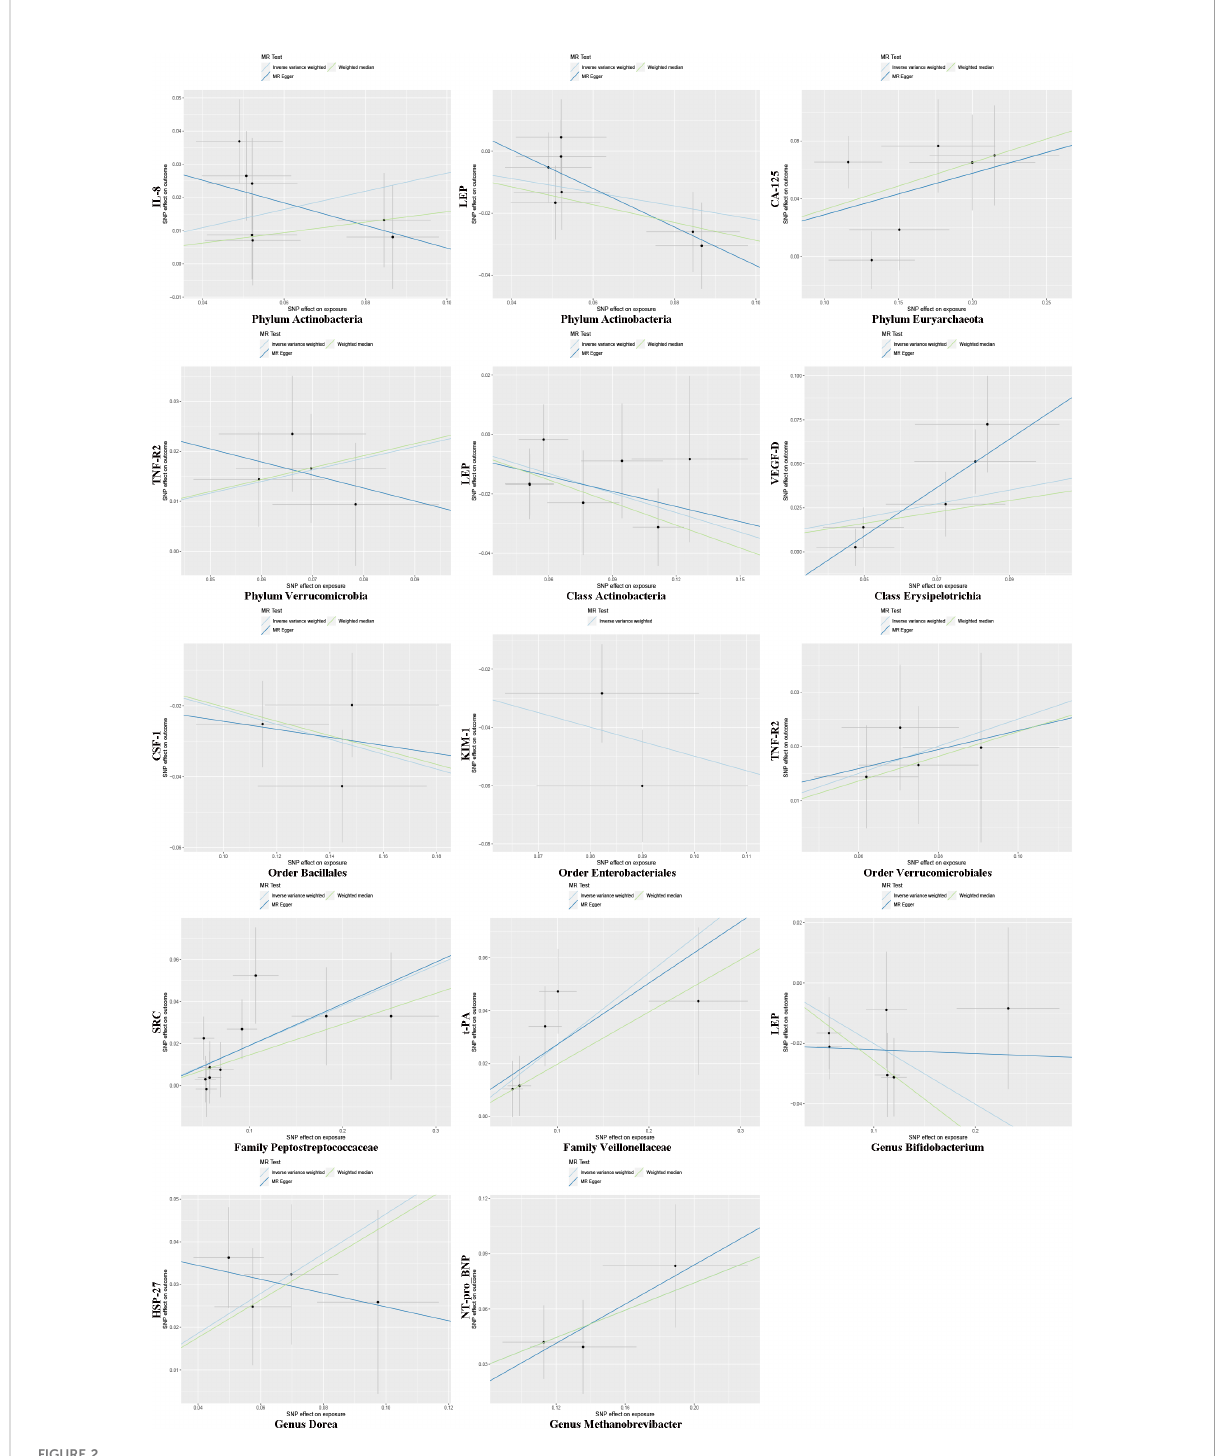
FIGURE 2 Mendelian randomization estimation using multiple SNPs. Light blue, green, and dark blue lines represent the association between microbiota (exposure) and cardiovascular proteins (outcome) estimated by the IVW method, weighted median estimator, and MR-Egger regression, respectively. Vertical and horizontal black lines around each point show the 95% con fi dence interval for each polymorphism exposure association and polymorphism outcome association, respectively. SNP, single nucleotide